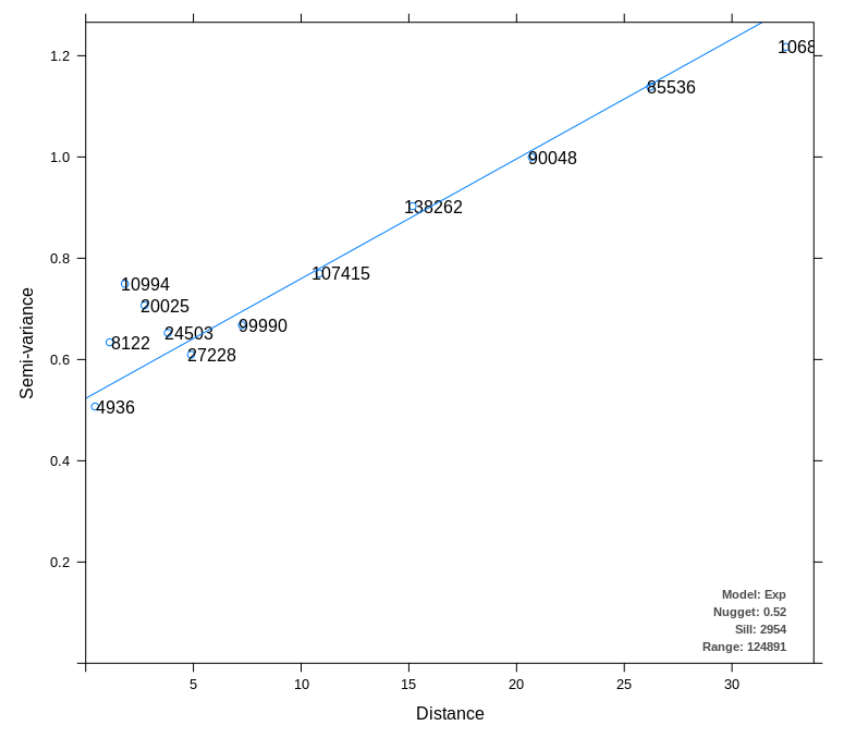
Figure 10. Variogram from the fitted model to O 3 data in the United States in 2015. This fitted model is the input for Kriging interpolation. Figure 11 shows the result of Kriging interpolation to O 3 data in the United States in 2015, where the gradient color repre- sents the O 3 AQI. If we chose an classical statistics methods to represent the same data (e.g., a simple average) like other literature works [23,24], we could obtain a map visualization like Figure 12; the colors in the map from Figure 12 follow the Table 4 definition.